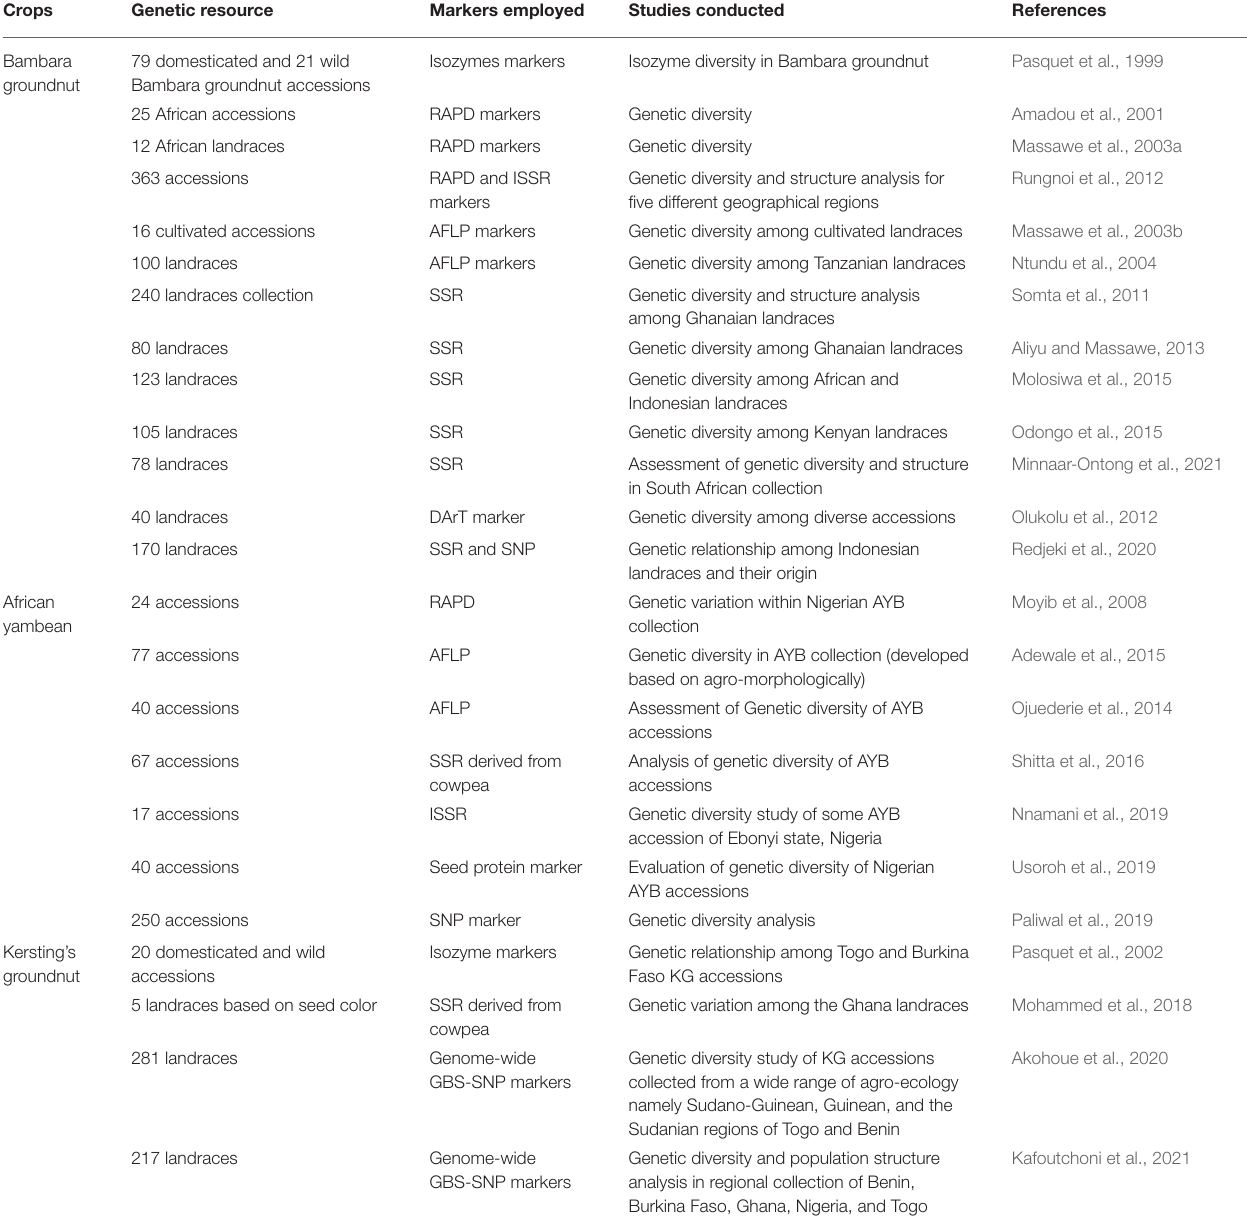
TABLE 3 | Plant genetic resources characterized using DNA markers in indigenous African Orphan